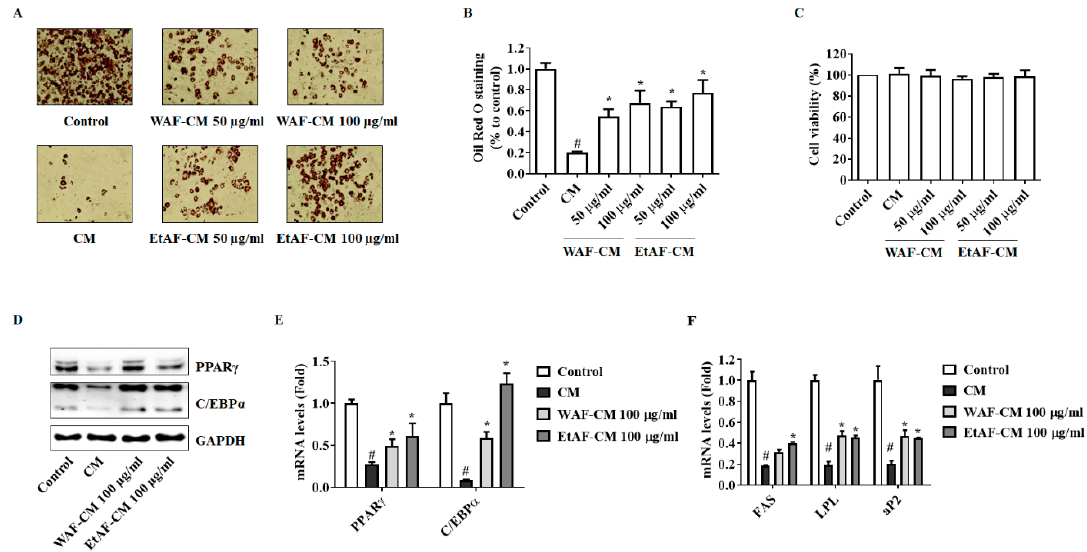
Figure 9. E ff ects of AF on the di ff erentiation of 3T3-L1 cell treated with conditioned media (CM) from CT-26 cells. Oil Red O staining images (200 × magnification) ( A ). Stained Oil Red O solution was resolved and measured ( B ). Cell viability was determined after incubating with CM treated with or without WAF-CM and EtAF-CM ( C ). The protein and mRNA levels of PPAR γ and C / EBP α in 3T3-L1 cells after fully di ff erentiation ( D , E ). GAPDH was used as an endogenous control. mRNA levels of FAS, LPL, and aP2 were measured ( F ). The results are from three independent experiments. All values are mean ± SD. # p < 0.05, significantly di ff erent from control group; * p < 0.05, significantly di ff erent from CM group.